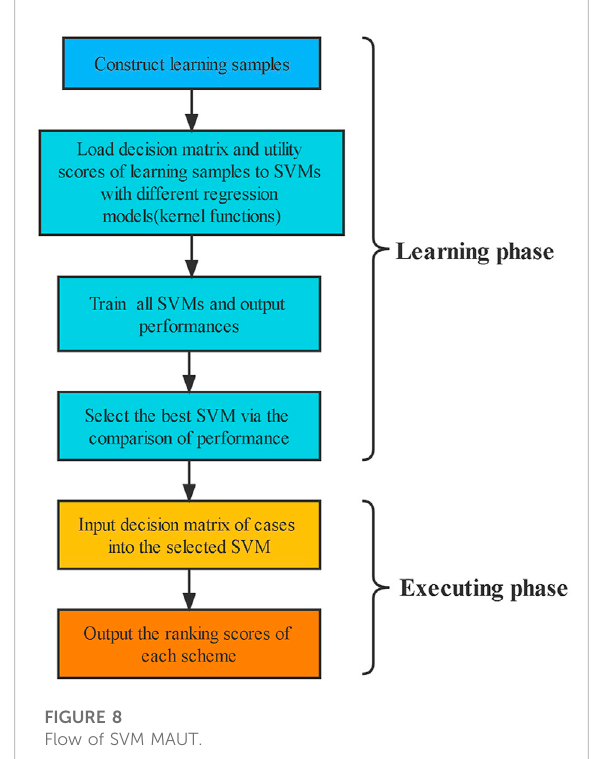
FIGURE 8 Flow of SVM